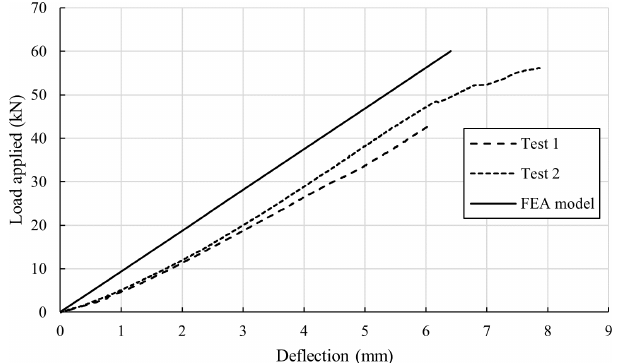
Figure 7. Deflection (mm) of the centre of the specimen against load (kN) applied during the testing (data for Test 3 not available).